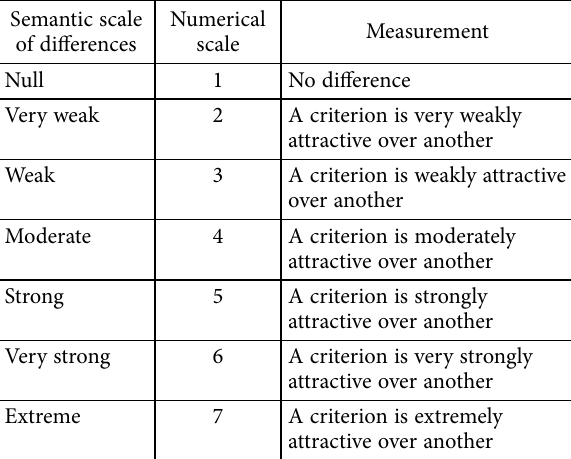
Table 2. MACBETH’s semantic scale of